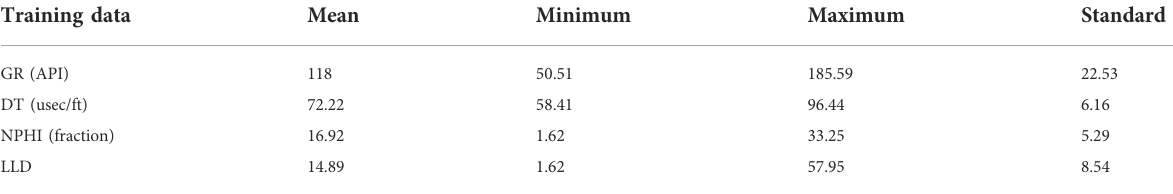
TABLE 4 Statistical description of the training data (average out of three wells, i.e., Kadanwari-01, -10, and -11). Training data